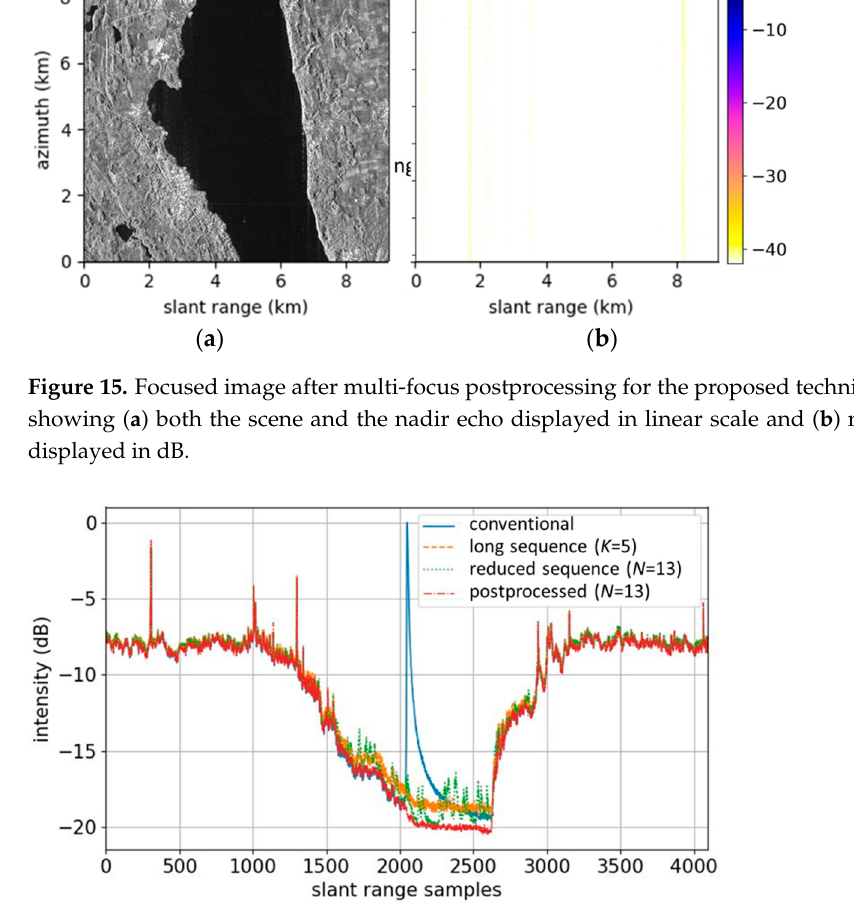
Figure 16. Averaged range profiles of the focused image for conventional SAR (blue), waveform variation using a very long sequence with K = 5 (orange), mere waveform variation using a sequence with only N = 13 distinct waveforms (green), and waveform variation and dual-focus postprocessing using a sequence with only N = 13 distinct waveforms (red).